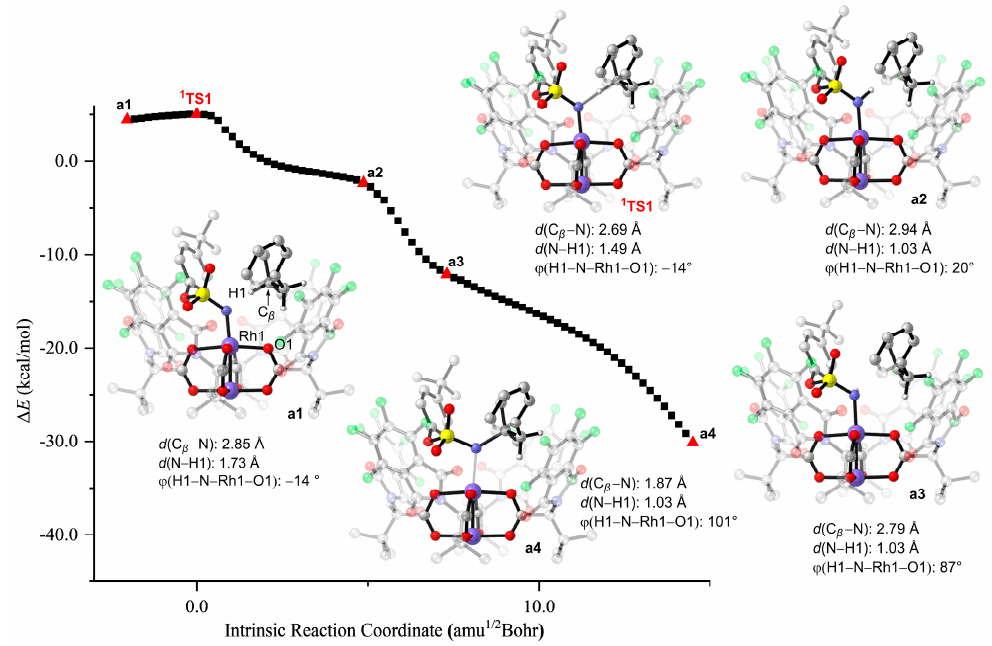
Figure 7. The IRC path for 1 TS1 . The H atoms of t Bu groups and aryl groups are omitted for